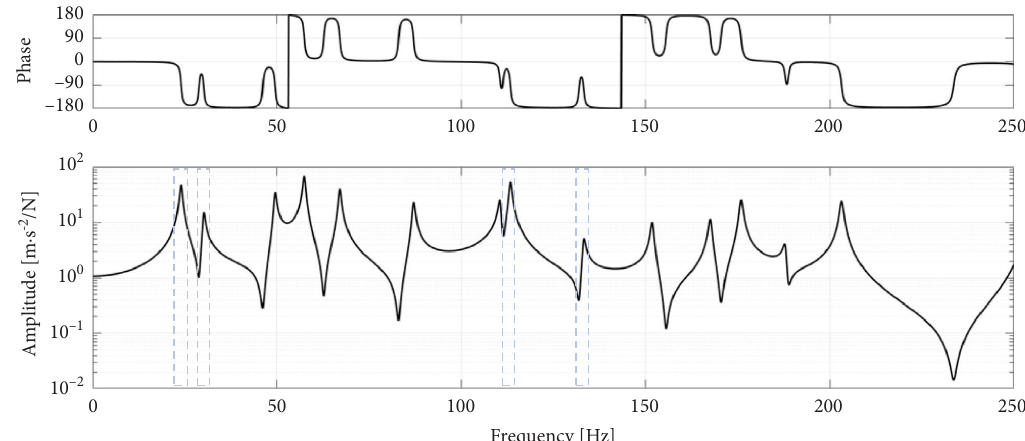
Figure 5: Acceleration FRF at the evaluation point.